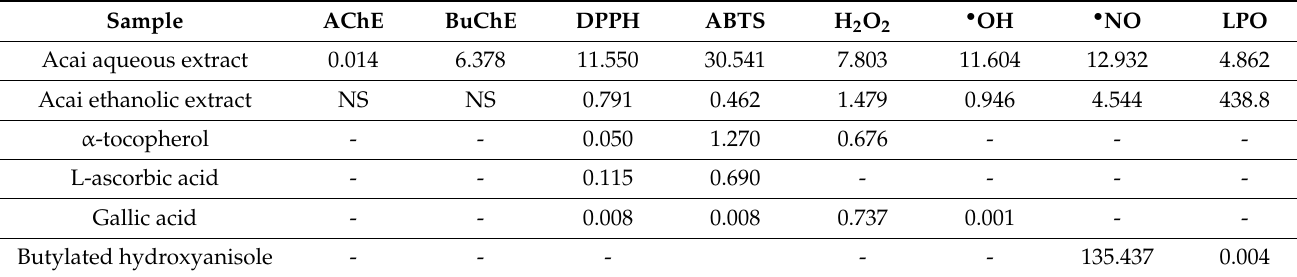
Table 1. The approximate IC 50 values (mg/mL) of acai aqueous extract, acai ethanolic extract, α - tocopherol (vitamin E), L-ascorbic acid (vitamin A), gallic acid, and butylated hydroxyanisole